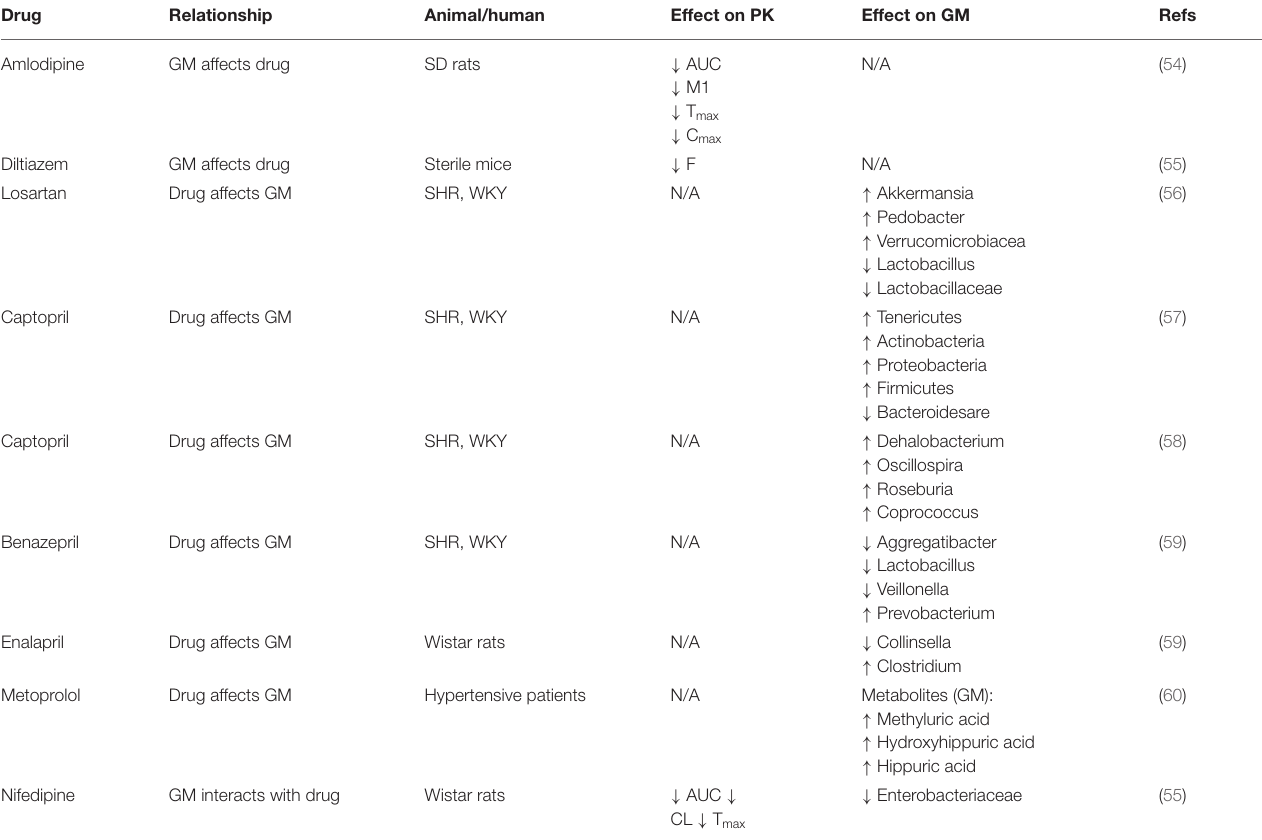
TABLE 1 | Drug-microbiome interactions of antihypertensive